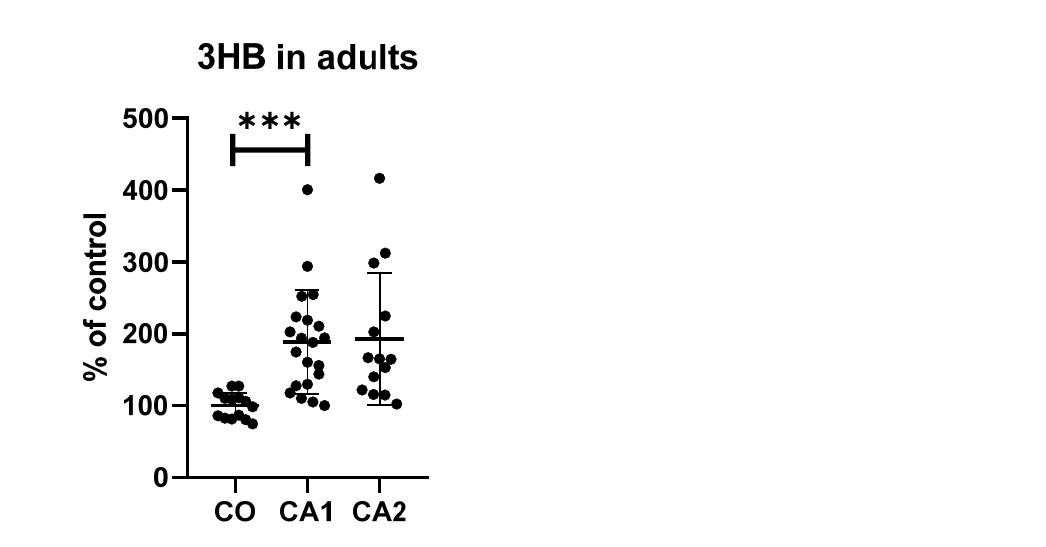
Figure 1. Levels of 3HB in adult patients and controls. CA1—case1, CA2—case2, CO—controls; *** p < 0.001.